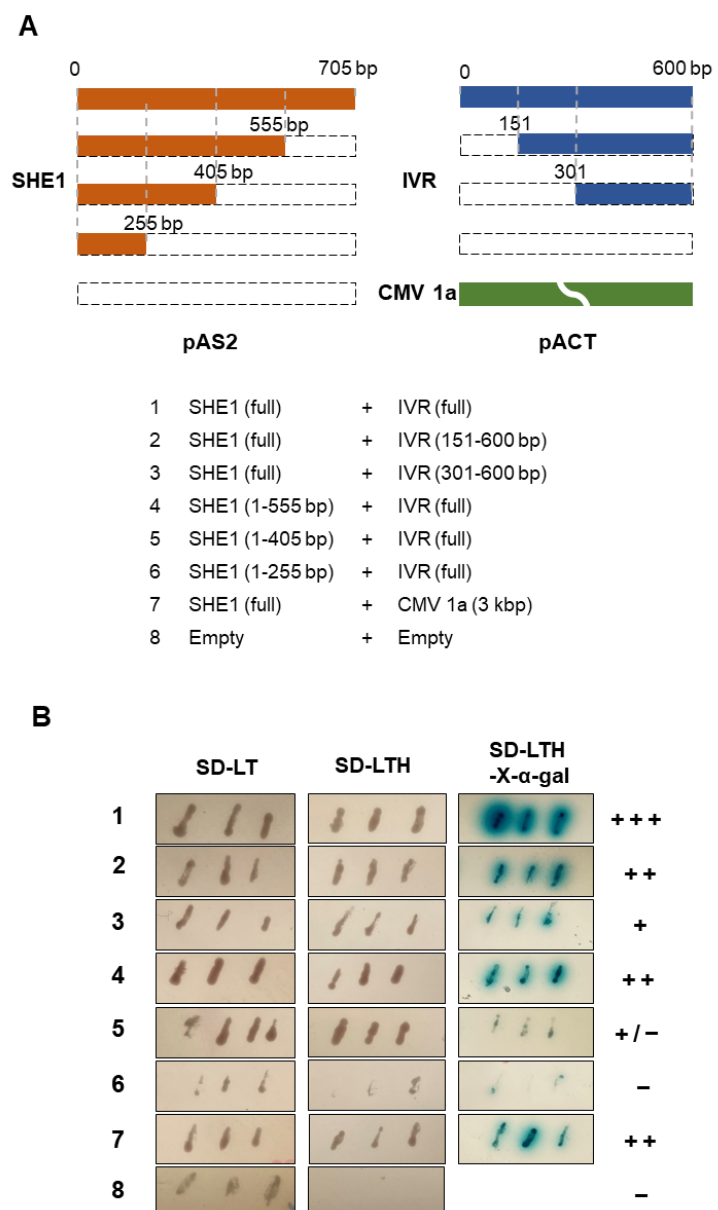
Figure 6. Yeast two ‐ hybrid assays for interaction of SHE1 with IVR. ( A ) Schematic presentation of Figure 6. Yeast two-hybrid assays for interaction of SHE1 with IVR. ( A ) Schematic presentation full ‐ length or partial C ‐ terminally deleted SHE1 genes (in the pAS2 vector) and full ‐ length or partial of full-length or partial C-terminally deleted SHE1 genes (in the pAS2 vector) and full-length or N ‐ terminally deleted IVR genes (in the pACT2 vector) used to co ‐ transform into yeast cells. ( B ) SD ‐ partial N-terminally deleted IVR genes (in the pACT2 vector) used to co-transform into yeast cells. L, SD ‐ T, SD ‐ LT and SD ‐ LTH represent assays in which transformants were selected on SD/ ‐ Leu, ( B ) SD-L, SD-T, SD-LT and SD-LTH represent assays in which transformants were selected on SD/ ‐ Trp, SD/ ‐ Leu/ ‐ Trp and SD/ ‐ Leu/ ‐ Trp/ ‐ His plates without X ‐α‐ gal, to detect the initiation of tran ‐ SD/-Leu, SD/-Trp, SD/-Leu/-Trp and SD/-Leu/-Trp/-His plates without X- α -gal, to detect the scription of amino acid biosynthesis reporter genes (LEU, TRP and HIS). The X ‐α‐ gal assay repre ‐ initiation of transcription of amino acid biosynthesis reporter genes (LEU, TRP and HIS). The X- α -gal sents colonies transferred to filters and assayed for reaction with X ‐α‐ gal; + = positive interaction; – assay represents colonies transferred to filters and assayed for reaction with X- α -gal; + = positive = negative interaction. SHE1 in pAS2 and CMV 1a in pACT were co ‐ transformed as a positive con ‐ interaction; – = negative interaction. SHE1 in pAS2 and CMV 1a in pACT were co-transformed as a trol. positive